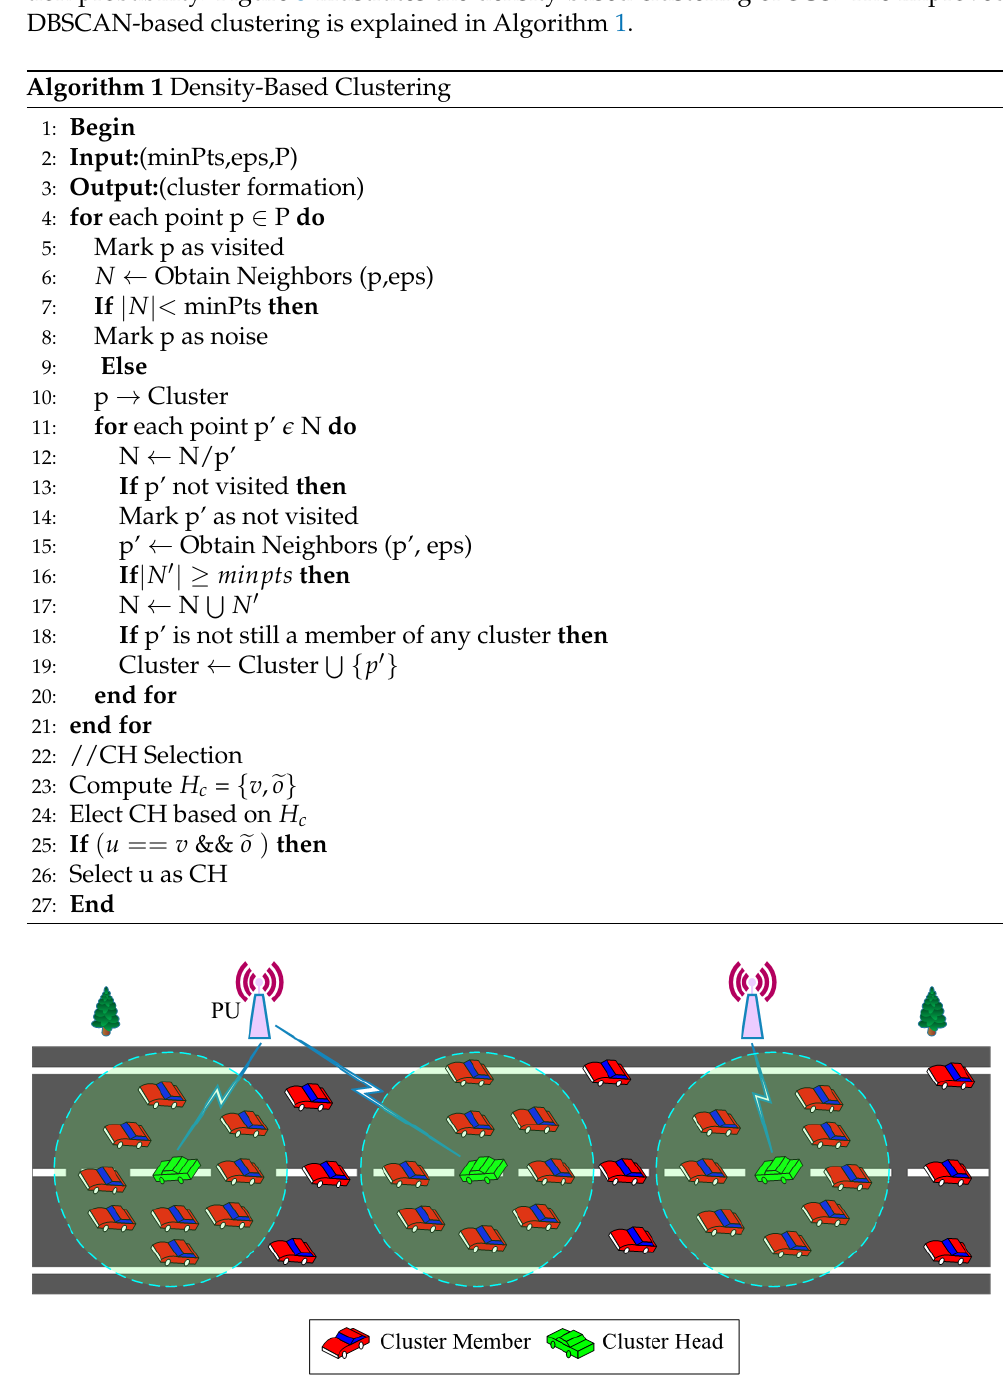
Figure 3. DBSCAN clustering of